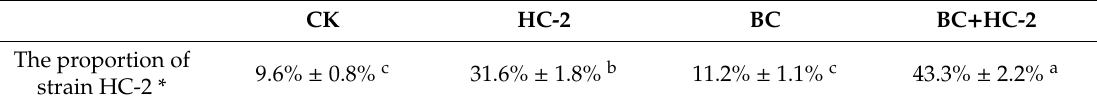
Table 1. The proportion of the tested strain in the rhizosphere soil of radish. The proportion of strain HC-2 * Data followed by the different letters (a–c) within the same line was significantly different ( p < 0.05) according to Tukey’s test. Average (±, standard deviations) of the proportion of strain HC-2 from three repetitive soil samples.